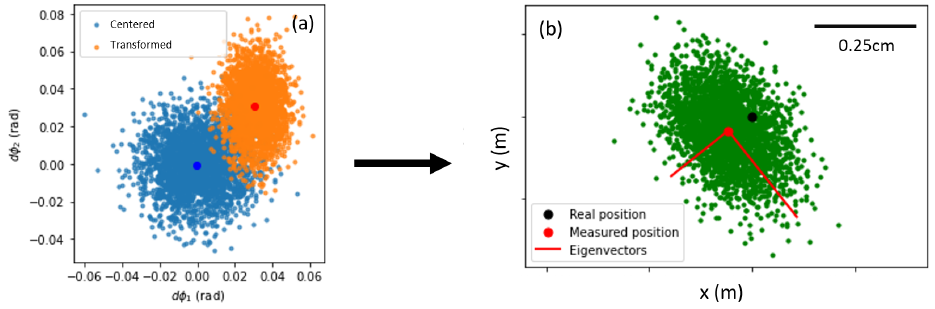
Figure 4. Schematic description of the matrix transformations in phase space towards real 2D space for a 2-antenna system. ( a ) Representation of the simulated multipath-induced phase measurement distribution (orange) compared to the previously assumed centered distribution (blue), highlighting the scaling S and translation T . The translation is illustrated by the shift between the center of the blue distribution and the center of the red distribution. ( b ) True space localization spot obtained by further transformation via the K − 1 matrix. The antennas are not represented. The systematic bias is again illustrated by the shift between the real position (black point) and the center of the measured distribution (red